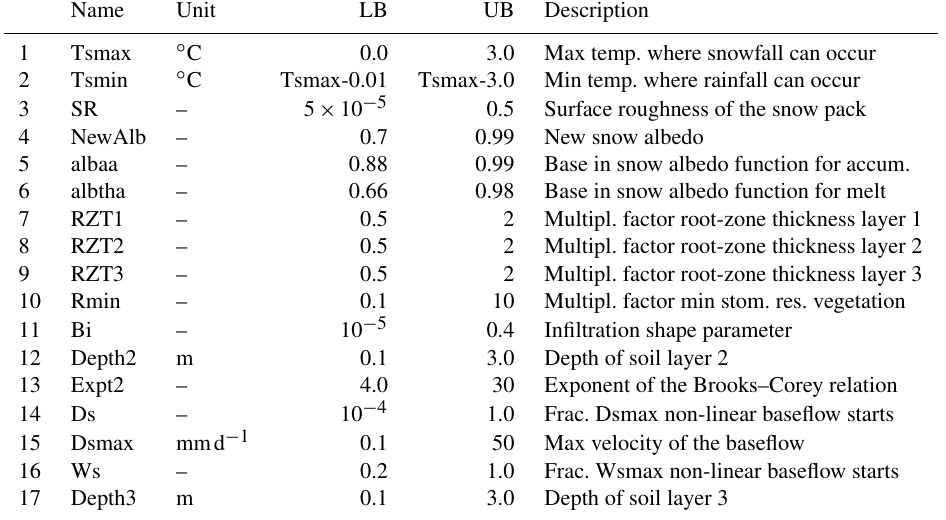
Table A3. Selected parameters and their boundaries for the VIC model based on Demaria et al. (2007), Chaney et al. (2015), Melsen et al. (2016), and Mendoza et al.